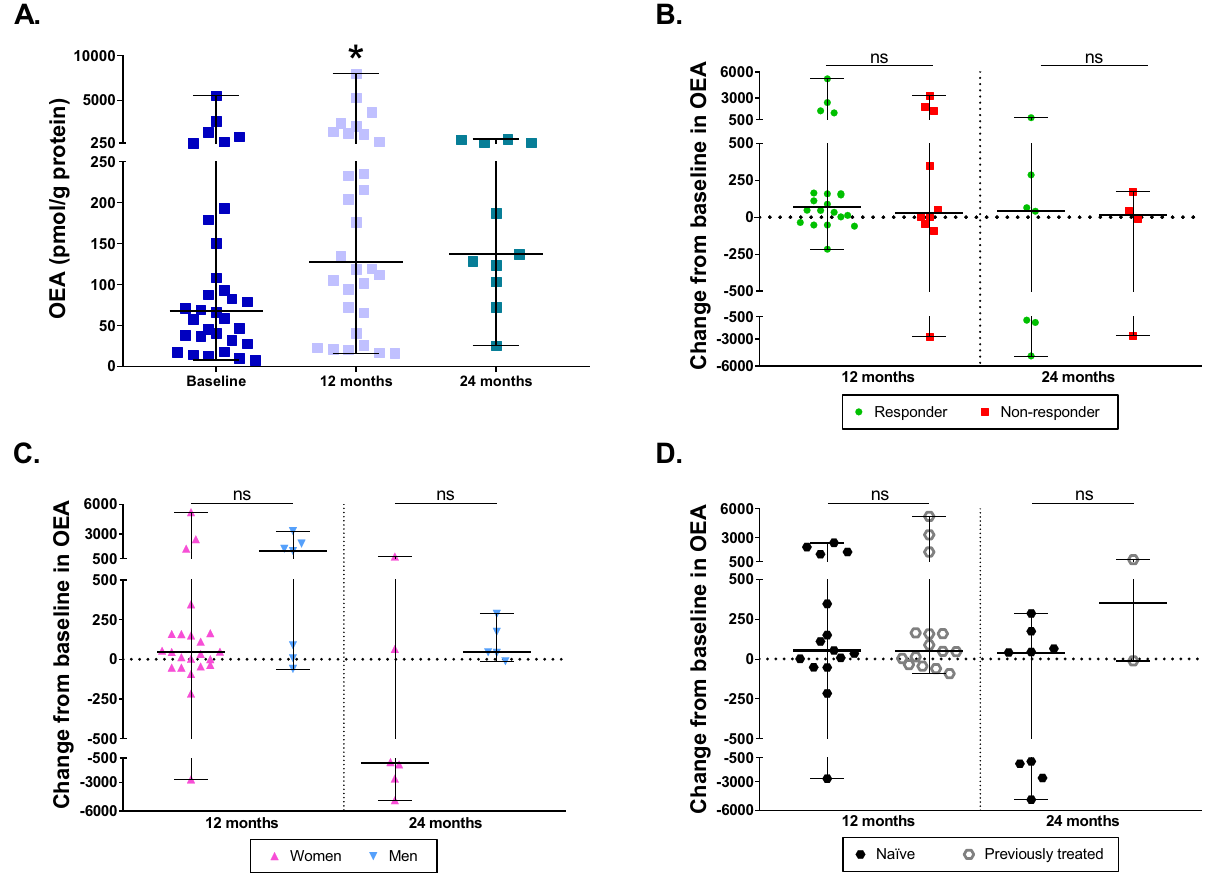
Figure 4. Characterization of OEA levels during DMF treatment. ( A ) OEA levels in MS patients at baseline and after 12 and 24 months of DMF treatment. ( B ) Changes in OEA levels at 12 and 24 months compared to baseline between responders and non-responders to DMF. ( C ) Changes in OEA levels at 12 and 24 months compared to baseline between women and men. ( D ) Changes in OEA levels at 12 and 24 months compared to baseline between naïve and previously treated patients. The Wilcoxon test was used to compare differences between the different time points and baseline, and the Mann–Whitney test was used to compared differences between subgroups. Data are expressed as median with range. *p < 0.05; ns, not